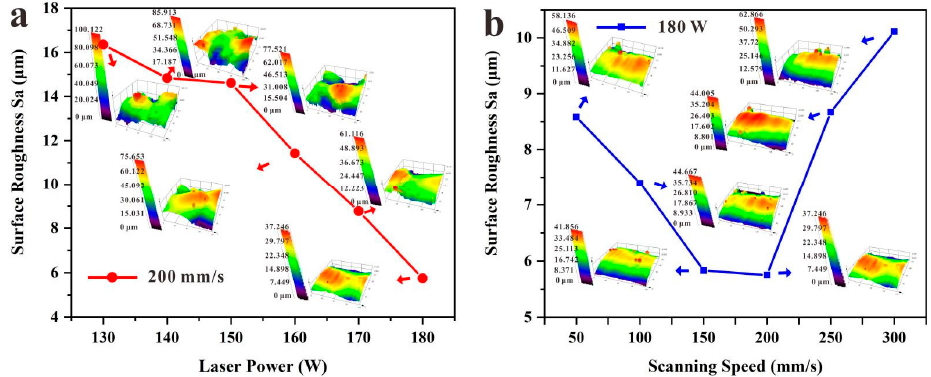
Figure 6. 1 vol.% copper-coated diamond/copper combined materials relationship between the sur- face roughness and ( a ) laser power and ( b ) scanning rate. surface roughness and ( a ) laser power and ( b ) scanning rate. 3.3. Comparison of the SLM Titanium and Copper-Coated Diamond/Copper Composites